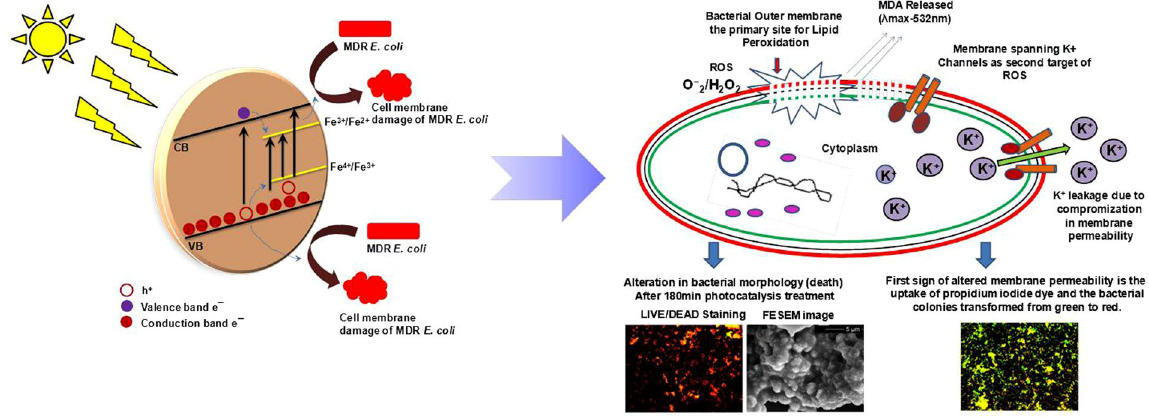
Figure 9. Schematic view of solar-photocatalytic disinfection of MDR E. coli in presence of Fe/ZnO